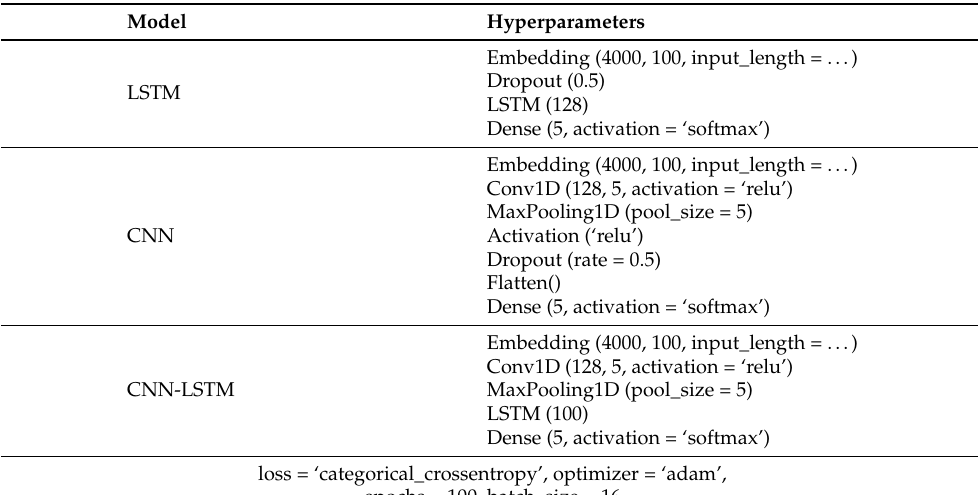
Table 15. Architecture of deep learning